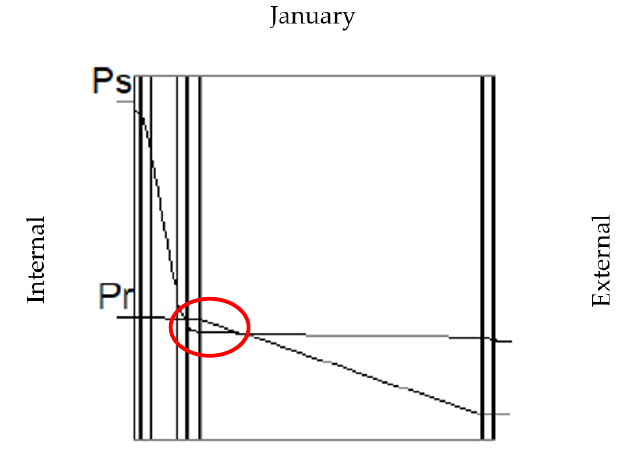
Figure 8. Extract from the diagram of monthly pressures referred to the month of January for wall type 5.1 (see also Annex A for further information). Condensation occurs in the region where the lines representing, respectively, the saturation (P s ) and relative (P r ) pressure intersect (red circle).